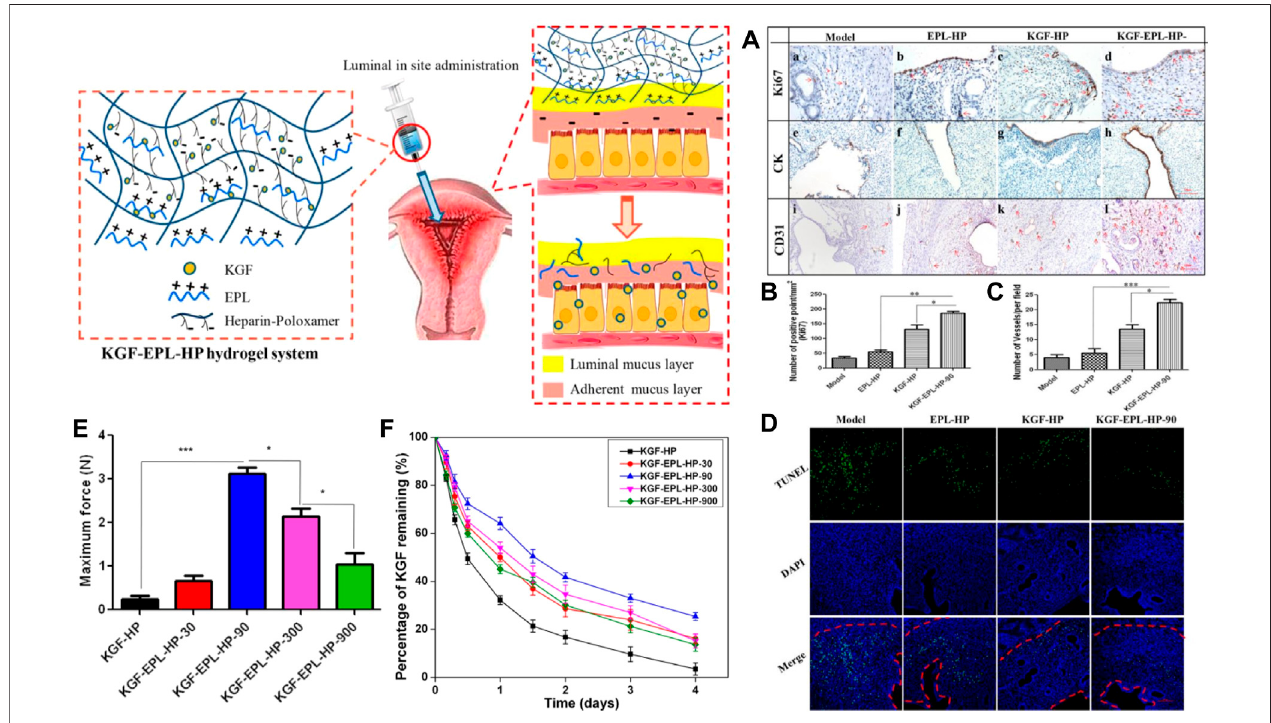
FIGURE 4 | Scheme of thermos-sensitive bioadhesive KGF-EPL-HP hydrogel for injured uterus. (A) Immunohistochemistry images of Ki67 (a – d), CK (e – h), and CD31 (i – l) staining for injured uterus on day 3 after treatments. Staining-positive cells were marked by red arrows (scale bar = 100 μ m). (B) Quantitative analysis of number of Ki67-positive cells, and (C) number of vessels per fi eld at day 3 after surgery. Original magni fi cation: ×200 (*: p < 0.05; **: p < 0.01; ***: p < 0.001 n = 3). (D) TUNELassayskitanalysisoftheinjuryuteruson3 daysaftertreatment.Redline:theborderofthebasallayer;blue:cellnuclei,DAPI;green:apoptosiscells.Original magni fi cation: ×200, scale = 1 μ m. Adhesive evaluation of KGF-EPL-HP hydrogel. (E) The adhesive force of KGF-EPL-HP hydrogels against gelatin substrate in comparisonwithHPhydrogels. (F) TheremainingpercentageofKGFonexcisedrabbituterinemucosaforKGF-EPL-HPhydrogelswithvariousEPLconcentrationsafter continuous rinsing with PBS (* p < 0.05; *** p < 0.001; n = 3). Reproduced with permission from ref (Xu et al., 2017a). Copyright 2017 American Chemical